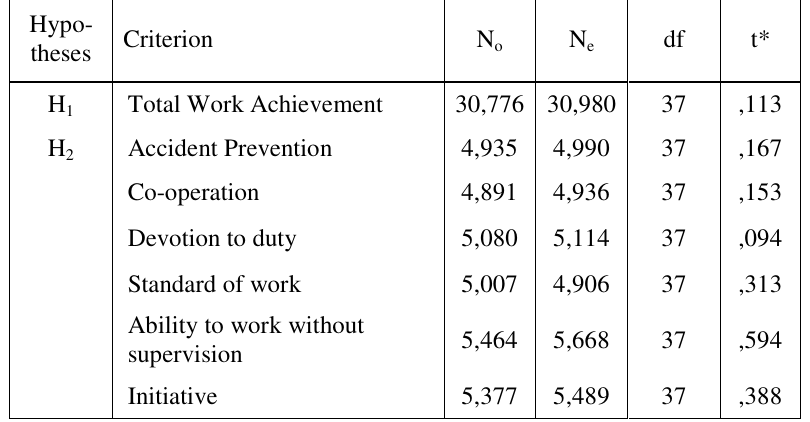
Test for Significance of Differences of Means for H and H : Reduced Group (N 1 2